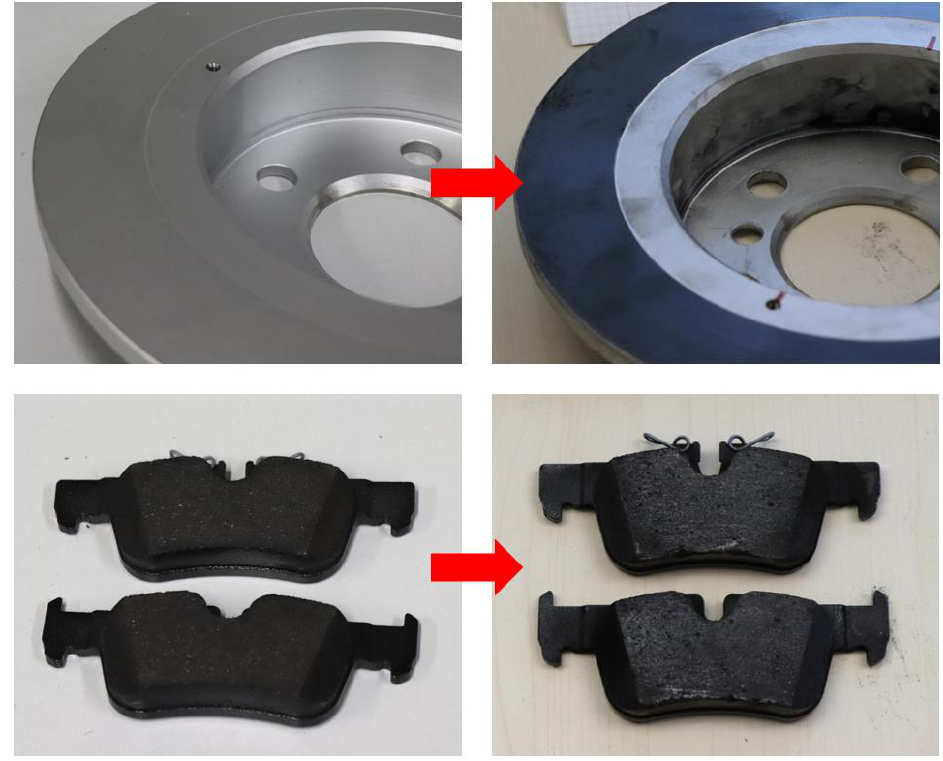
Figure A5. Original brake disc and brake pads of the test vehicle BMW i3 before and after the experiments.